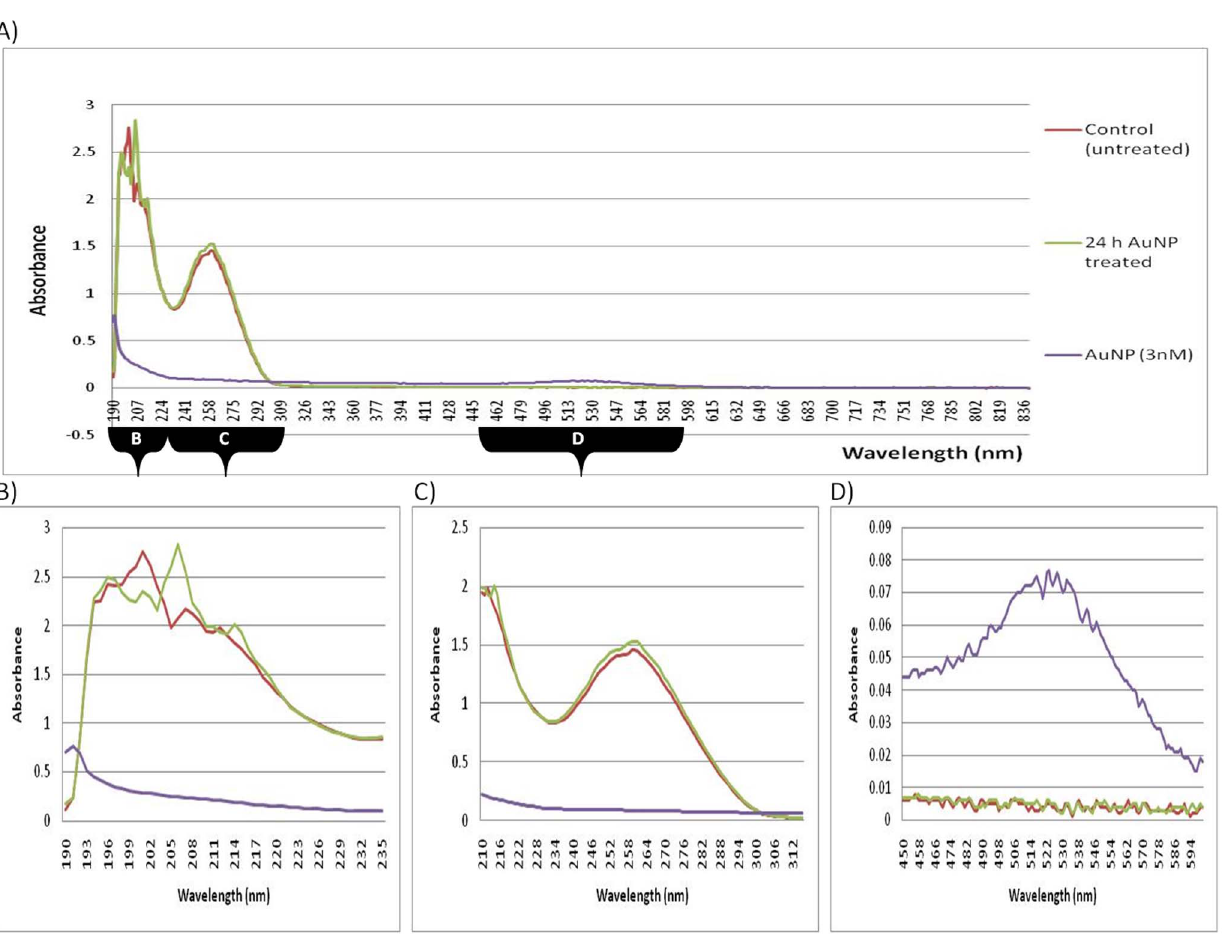
Figure 3. UV-Vis spectroscopy of RNA from 24 h AuNP-treated samples. ( A ) Full spectrum absorbance analyses of RNA obtained from 24 h AuNP- treated cells, measured at wavelengths from 190–840 nm. ( B ) Peak shifts of absorption spectra of RNA obtained from 24 h AuNP-treated cells, measured at wavelengths from 190–235 nm. ( C ) Traditional absorbance spectrum analyses of RNA obtained from 24 h AuNP-treated cells, measured at wavelengths from 220–340 nm. ( D ) Absorption spectra of RNA obtained from 24 h AuNP-treated cells, measured at wavelengths from 450–600